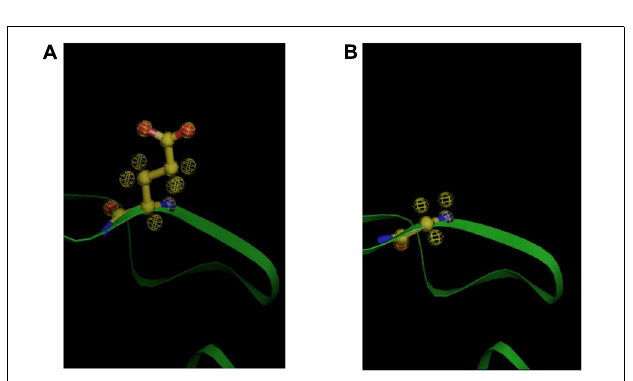
FIGURE 7 | Structure predication for the folP gene products (dihydropteroate synthase) of S. acidaminiphila SUNEO and JCM 13310. (A) Glu72 in the SUNEO dihydropteroate synthase. (B) Gly72 in the JCM 13310 dihydropteroate